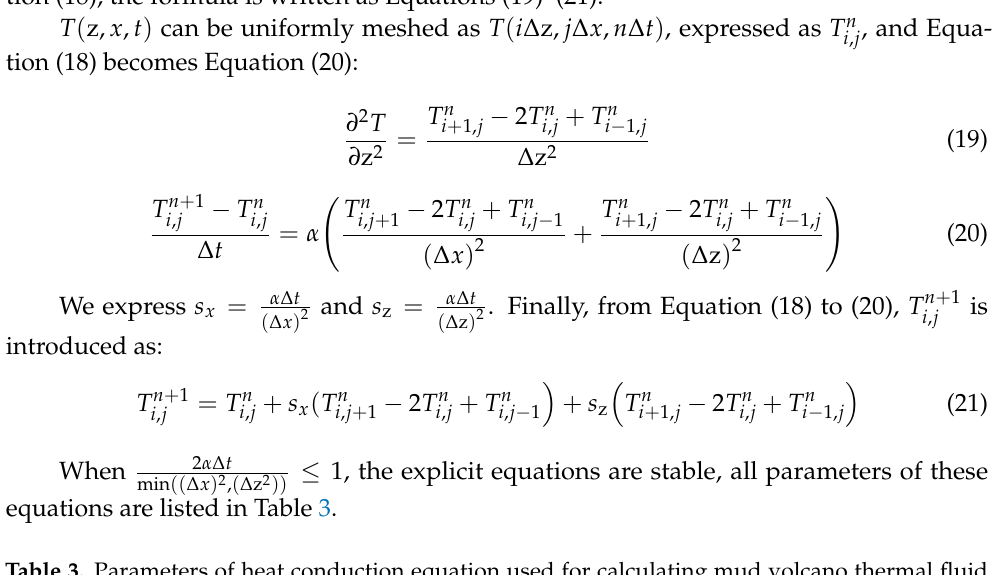
Table 3. Parameters of heat conduction equation used for calculating mud volcano thermal fluid effects on surrounding sediment. Parameter Unit α thermal diffusivity coefficient of each layer m 2 /s ρ density of each layer kg/m 3 c p specific heat capacity of each layer J/(kg · k) k x thermal conductivity in x direction of each layer W/(m ·